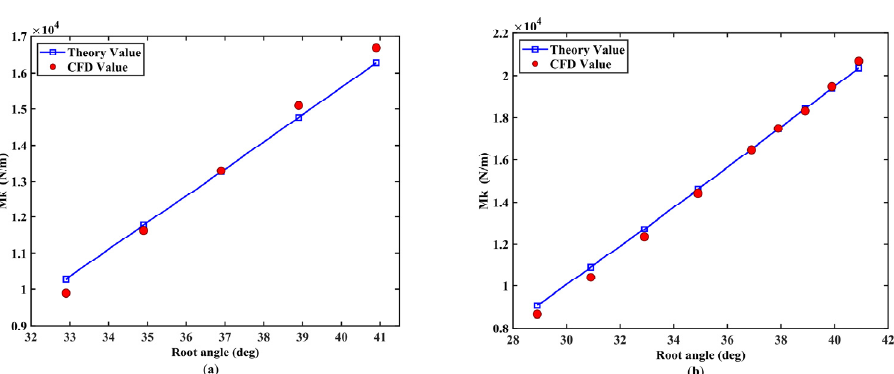
Figure 20. RL fitted curve.